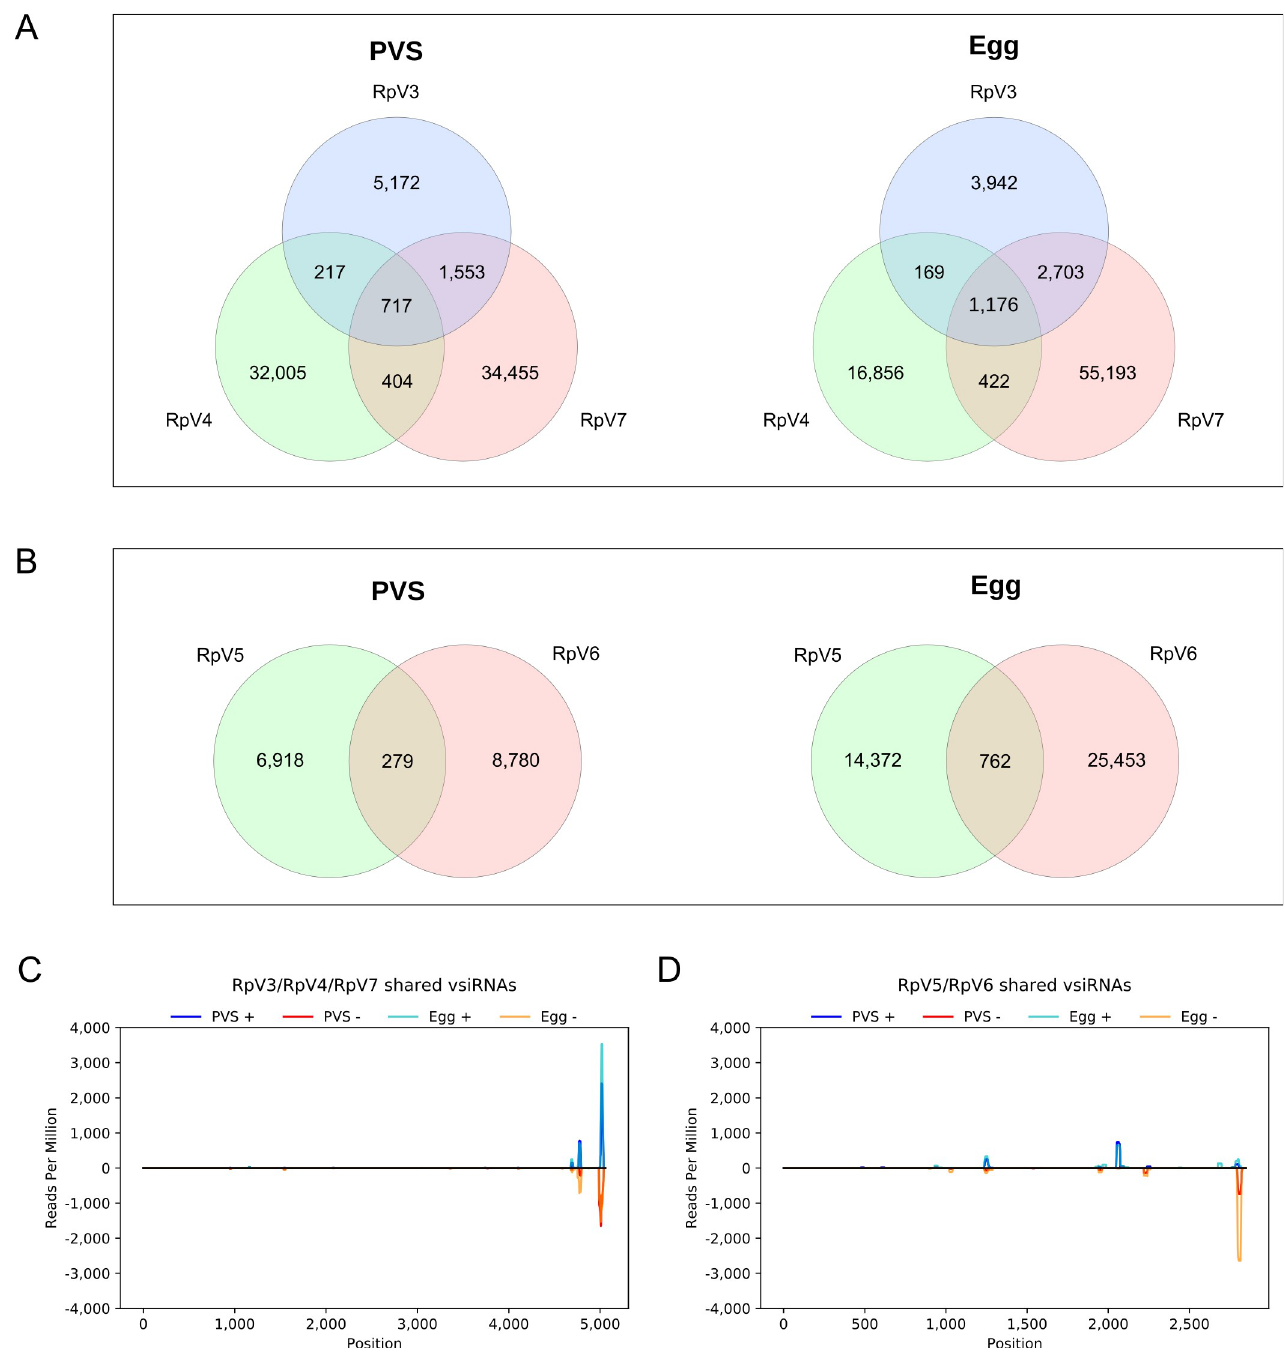
Fig 4. Analysis of the vsiRNA pools shared by the RpVs. (A) Venn diagram showing the vsiRNAs expressed in PVS and Egg stages that are shared by the permutotetraviruses. (B) Venn diagram showing the vsiRNAs expressed in PVS and Egg stages that are shared by the sobemoviruses. Only vsiRNAs with perfect match to the viral genomes were considered in these analyses. (C) Small RNA-Seq coverage of the vsiRNAs simultaneously shared by the permutotetraviruses RpV3, RpV4 and RpV7. The coverage along the consensus genome (see Methods) is displayed to highlight the accumulation of the shared vsiRNAs in the viral 3’UTR. Similar results were obtained for the RpV4 and RpV7 genomes (S7 Fig). (D) Small RNA-Seq coverage of the vsiRNAs common to the sobemoviruses RpV5 and RpV6. Sense and antisense shared vsiRNAs detected in previtellogenic stages of oogenesis (dark blue = sense, red = antisense) and mature chorionated eggs (light blue = sense, orange = antisense) are